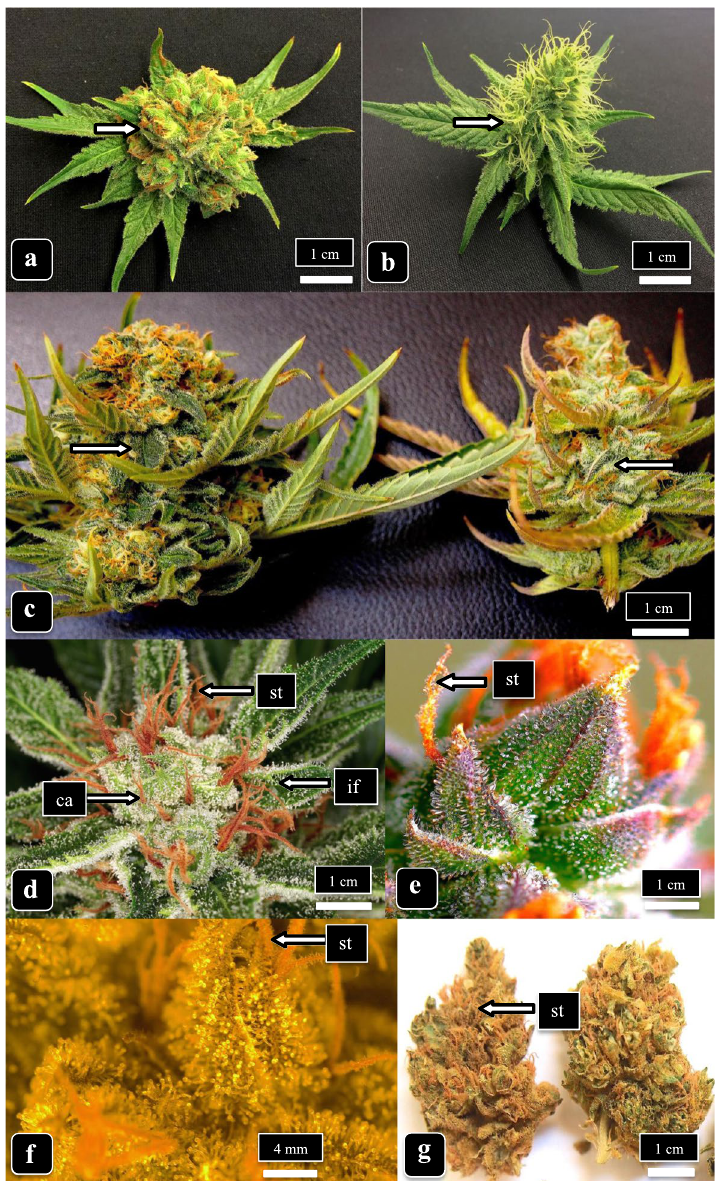
Fig. 1 Morphology of developing inflorescences in the two cannabis genotypes examined in this study. a “Moby Dick” (MD) at 3 weeks of inflorescence development. b “Space Queen” (SQ) at 3 weeks. c MD (left) and SQ (right) at 6 weeks. The arrows in a – c show the positions at which bracts were sampled for microscopic observations. d Stigmas (st) appear orange-brown in color and trichomes can be seen on the calyx (ca.) and on inflorescence leaves (il) of strain MD at 8 weeks. e , f Trichomes on bracts of strain SQ at 8 weeks. The arrow points to stigmas (st) that appear orange-brown. g Dried inflorescence (bud) of MD after harvest. The bud has been trimmed to remove the inflorescence leaves. The arrow points to dried stigmas